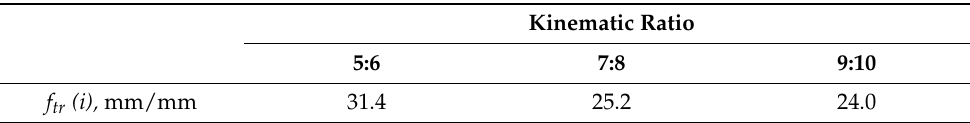
Table 4. Numerical values of function f tr (i)